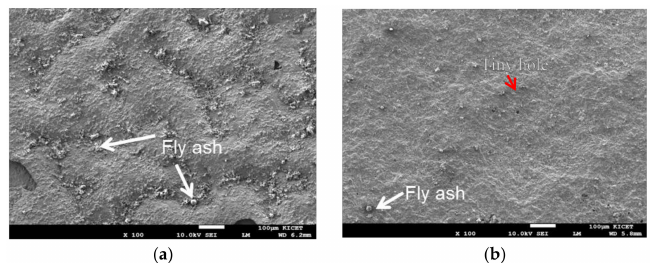
Figure 8. Top-view SEM images of ( a ) non-coated steel and ( b ) coated steel after the anti-fouling